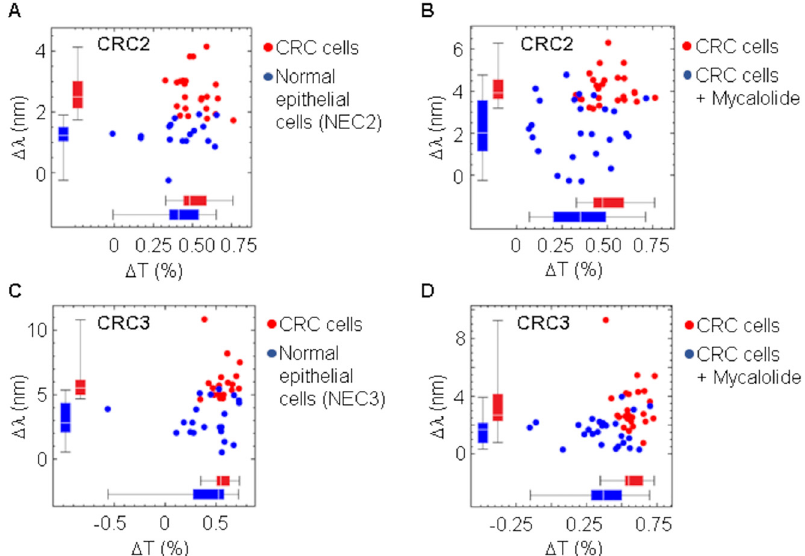
Figure 12: Spectral changes in CRC cells form surgical specimens. (A, C) Spectral shift and change in transmittance comparing isolated CRC cells and normal epithelial cells (NEC) obtained from two different patients,CRC2andCRC3.(B,D)SpectralshiftandchangeintransmittancecomparingisolatedCRC2andCRC3cellswithoutandwithprevious treatment with 5 μ M mycalolide B. Sensitivity and speci fi city of the assays were 91 and 89% (threshold set to 1.8 nm) in (A), 76 and 86% (threshold set to 3.5 nm) in (B), 80 and 100% (threshold 4.5 nm) in (C), and 72 and 81% (threshold set to 2.3 nm) in (D), respectively.